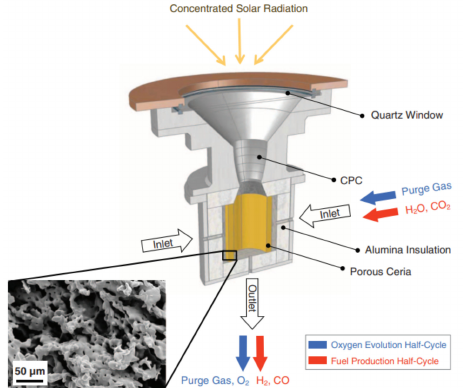
Figure 2. Schematic representation of the solar reactor used for thermochemical water splitting. The redox material used in porous ceria. As the same setup was used in another experiment for syngas production, carbon dioxide and carbon monoxide are also denoted in the figure, as well as a scanning electron microscope image of ceria after 23 cycles. Reprinted from